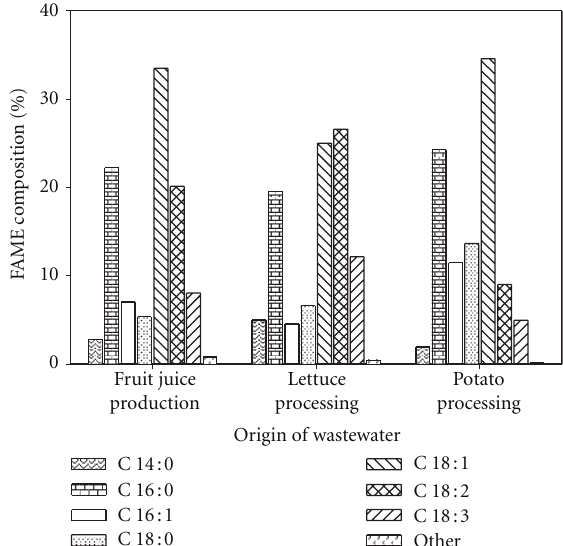
Figure 5: FAME composition of transesterified microbial lipid after 48 hours of cultivation with R. glutinis on di ff erent wastewaters.